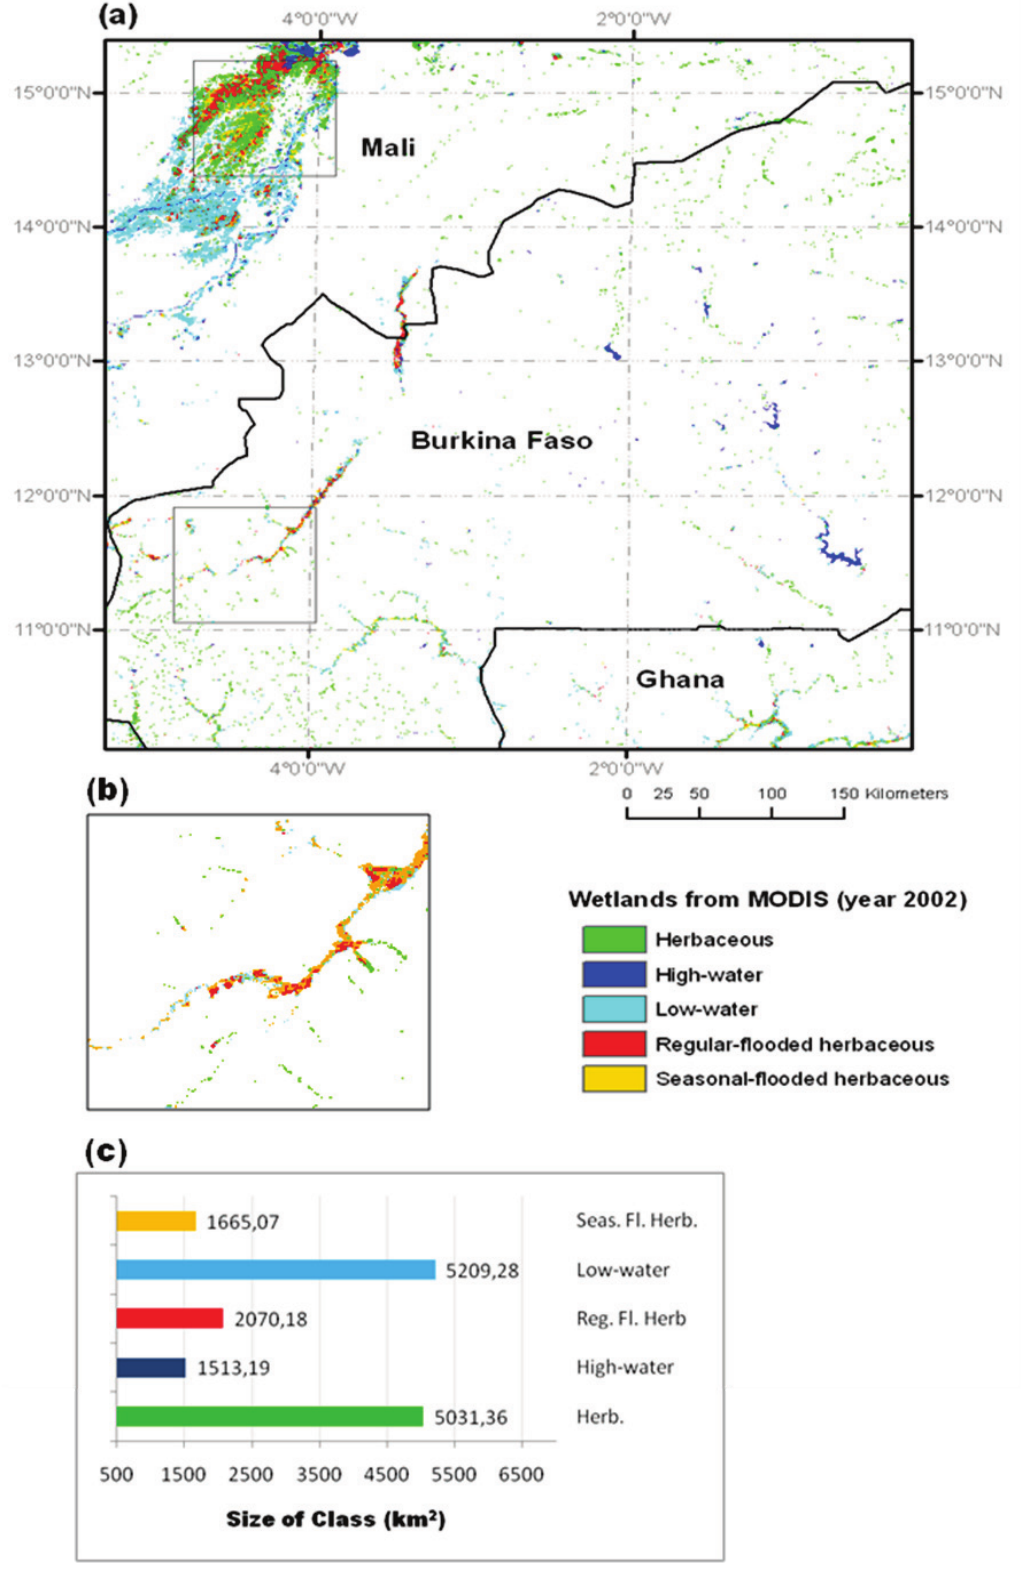
Figure 3. (a). Mapped wetlands over the whole study region. Solid line grey squares show the Landsat reference site locations. (b). zoomed map for the RAMSAR site La Mare Hippotames. (c). Bar chart showing the size of each of the five wetland classes in km 2